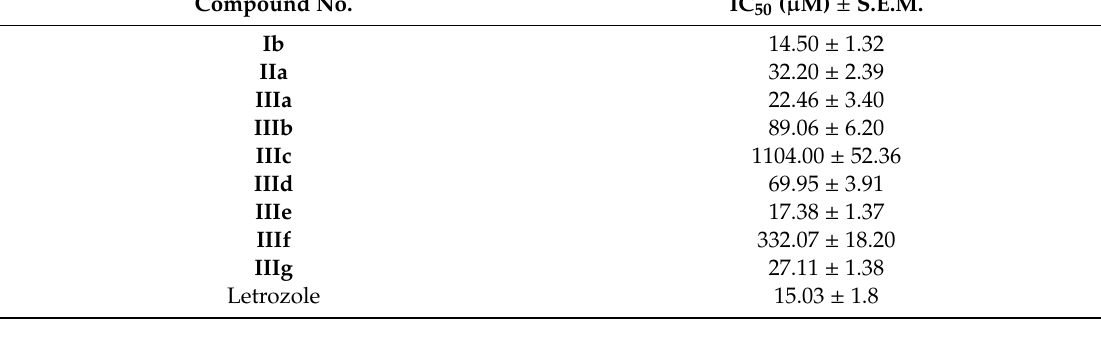
Table 4. Aromatase inhibition activity of the selected synthesized compounds and letrozole. Compound No.